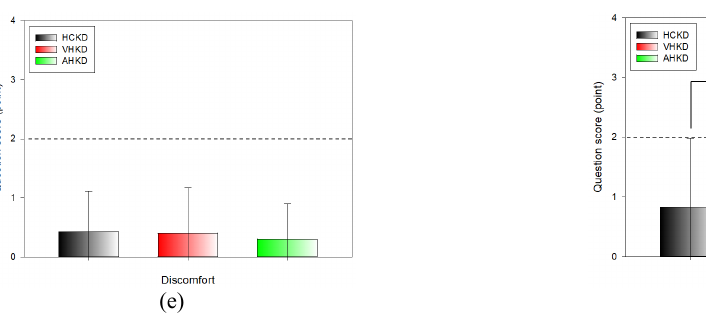
Figure 7. Results of subjective symptoms between K-D tests(*: p < 0.05) (a) Dizziness, (b) Diplopia, (c) Definition, (d) Legibility, (e) Discomfort, (f) Ocular fatigue